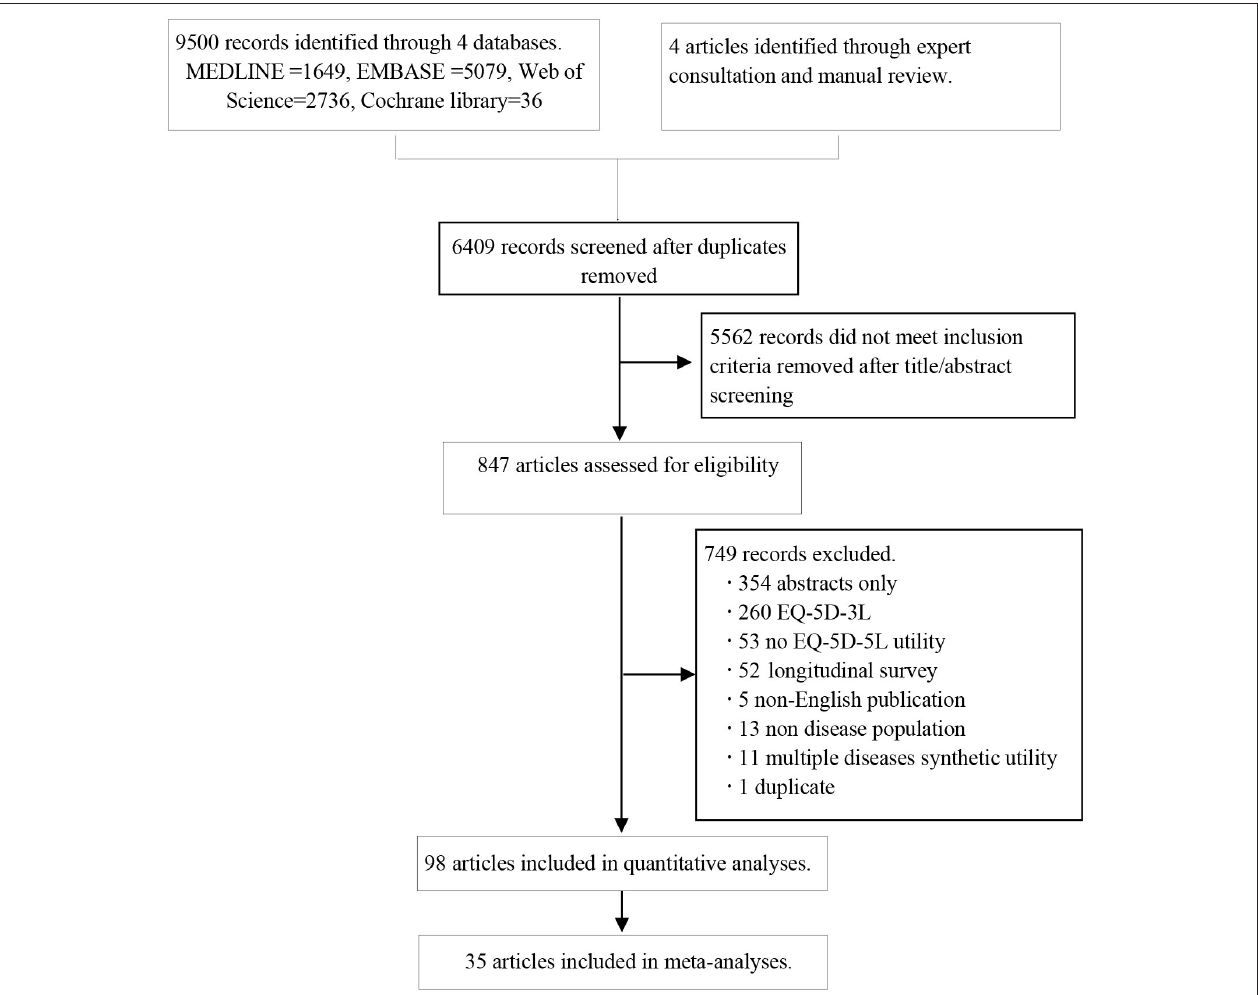
FIGURE 1 | Flow diagram of article selection for